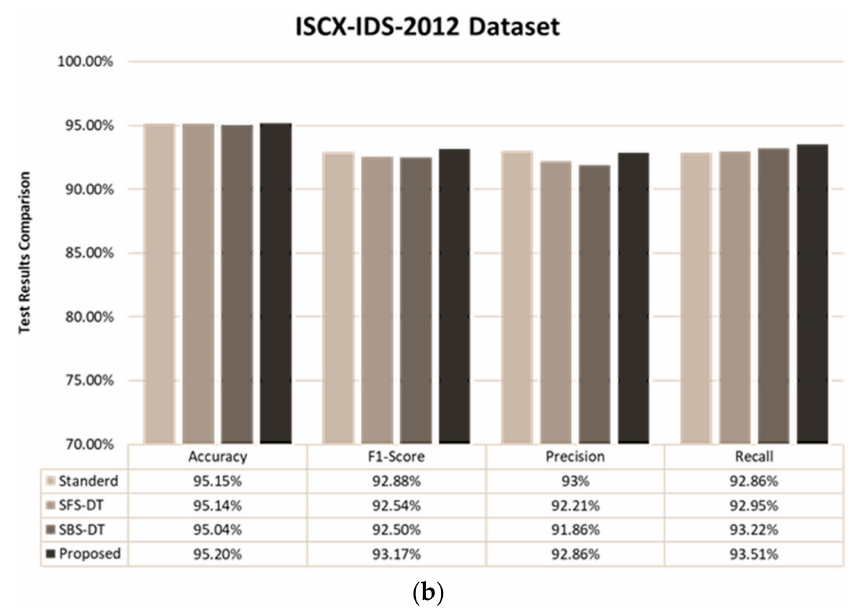
Figure 4. Test results based on each feature selection method: ( a ) results of the CIC-IDS 2017 dataset, and ( b ) results of the ISCX-IDS 2012 dataset.